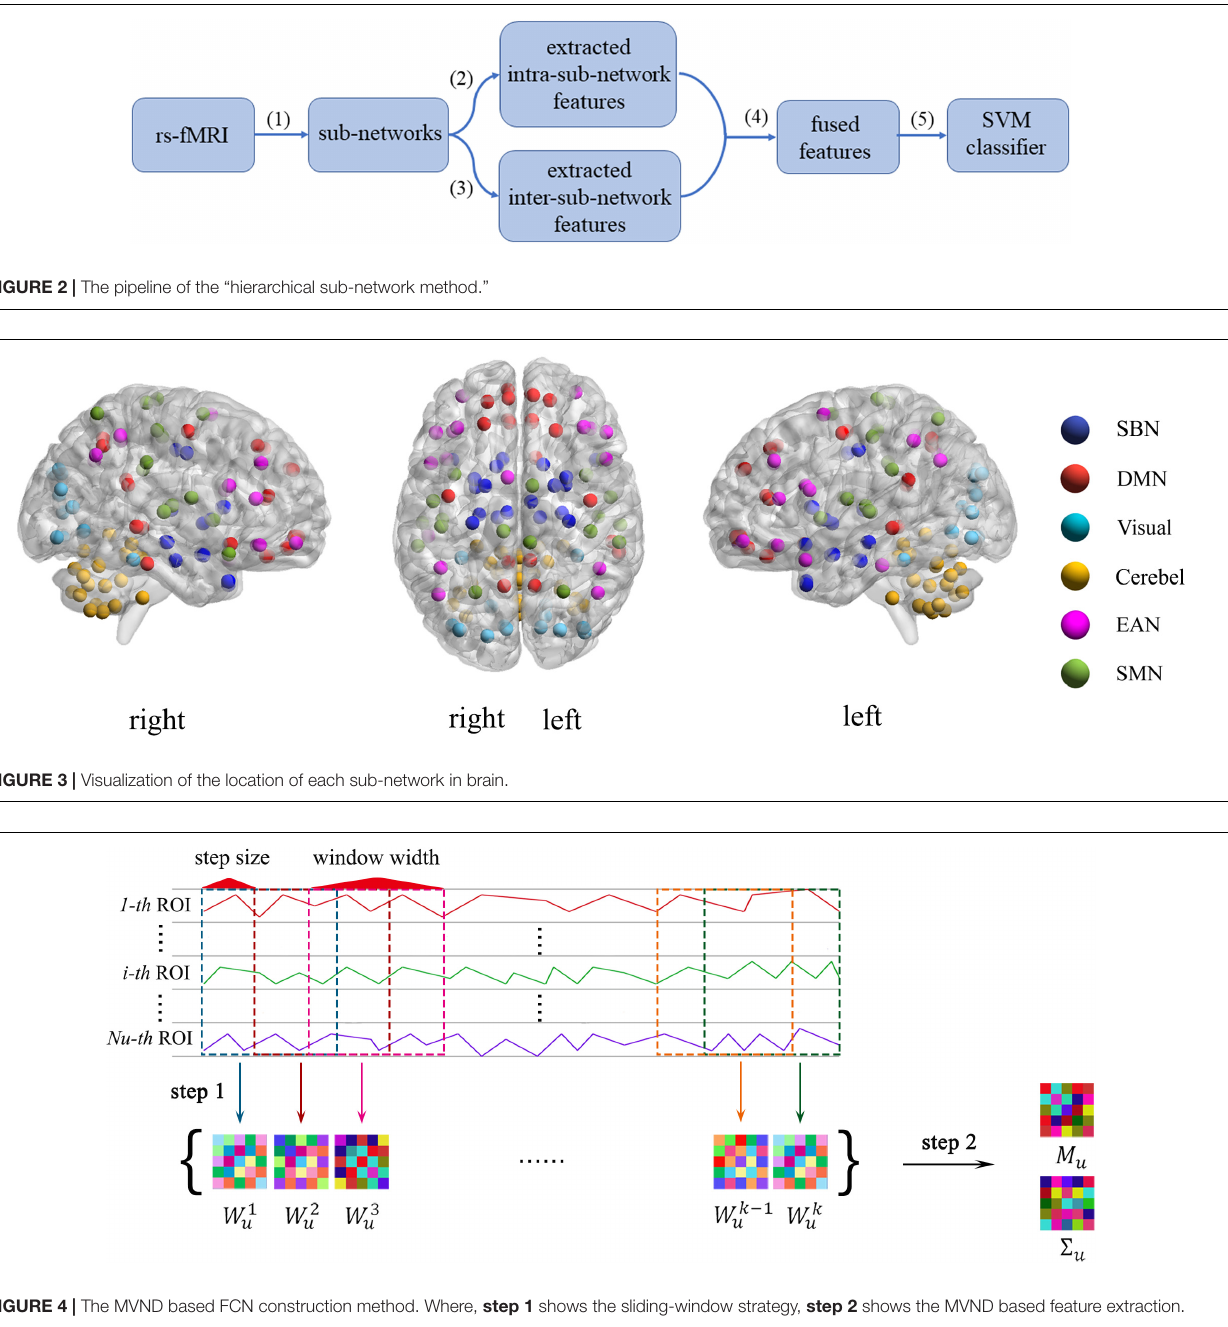
FIGURE 4 | The MVND based FCN construction method. Where, step 1 shows the sliding-window strategy, step 2 shows the MVND based feature